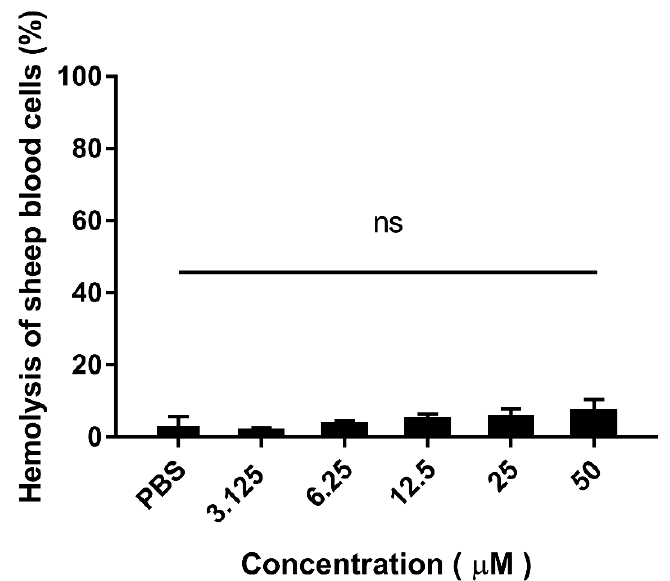
Figure 6. Hemolytic effect of purified hybrid peptide EF-1 in contradiction of sheep RBCs. The data resemble the mean ± standard deviation; ns—not significant.